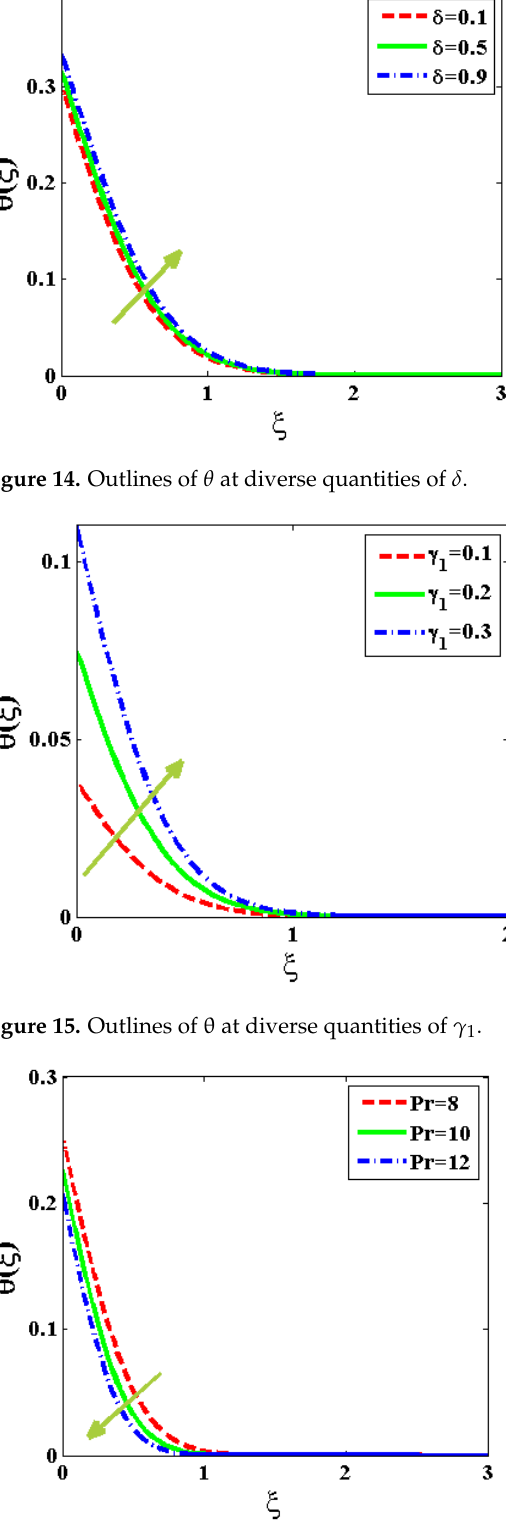
Figure 16. Outlines of 𝜃 at diverse quantities of 𝑃𝑟 .